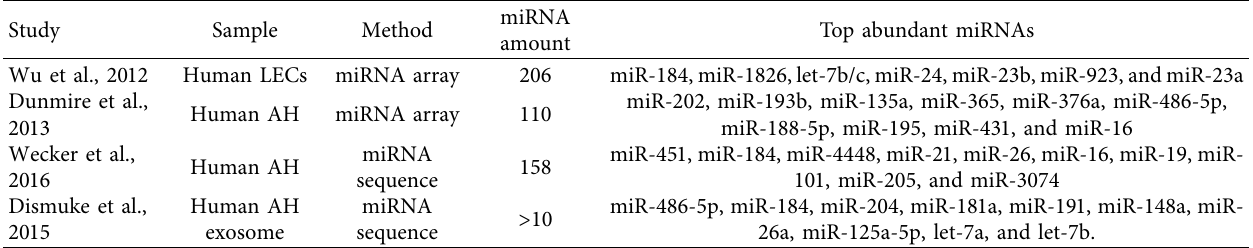
Table 1: The top miRNAs expression in human LECs, AH, and AH